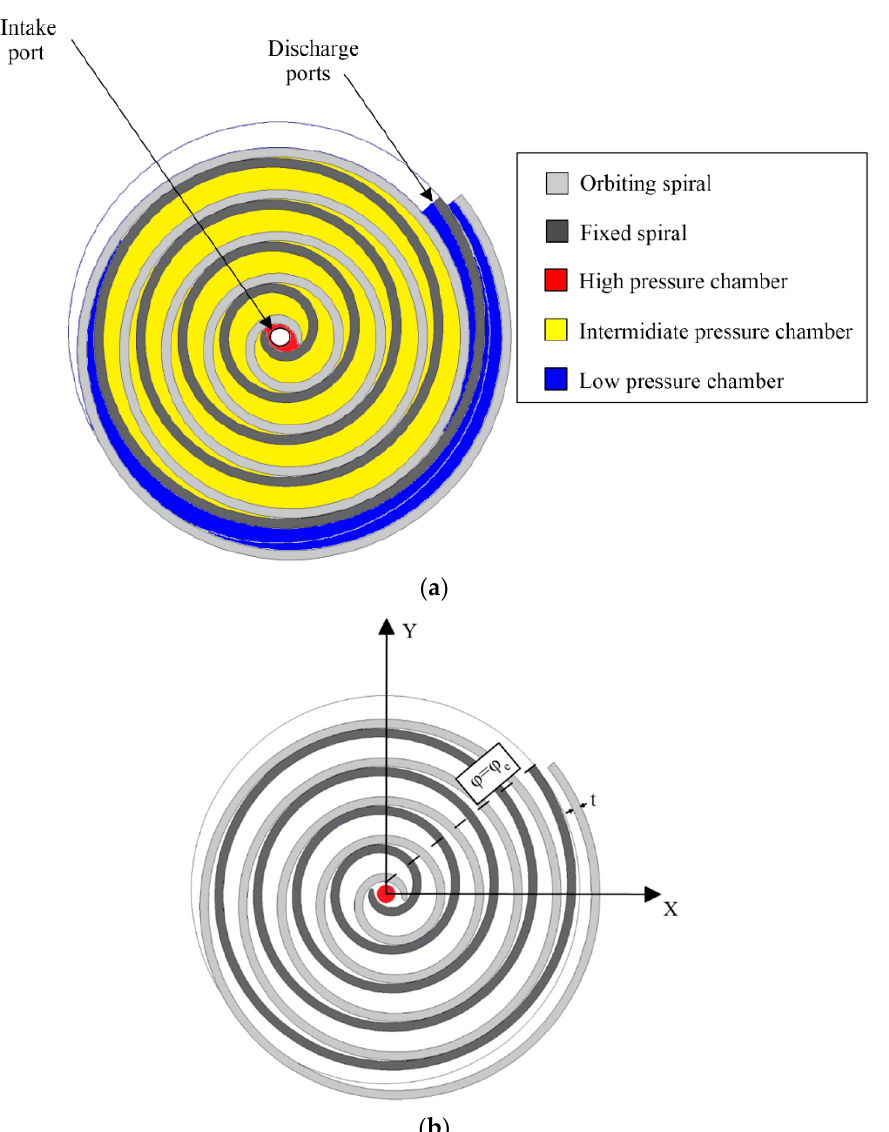
Figure 2. ( a ) Representation of the stationary and orbiting scrolls and the chambers identified during the expansion process [35]; ( b ) main parameters of a scroll geometry, composed of inner and outer involutes spaced away from each other by a specific distance t [36].